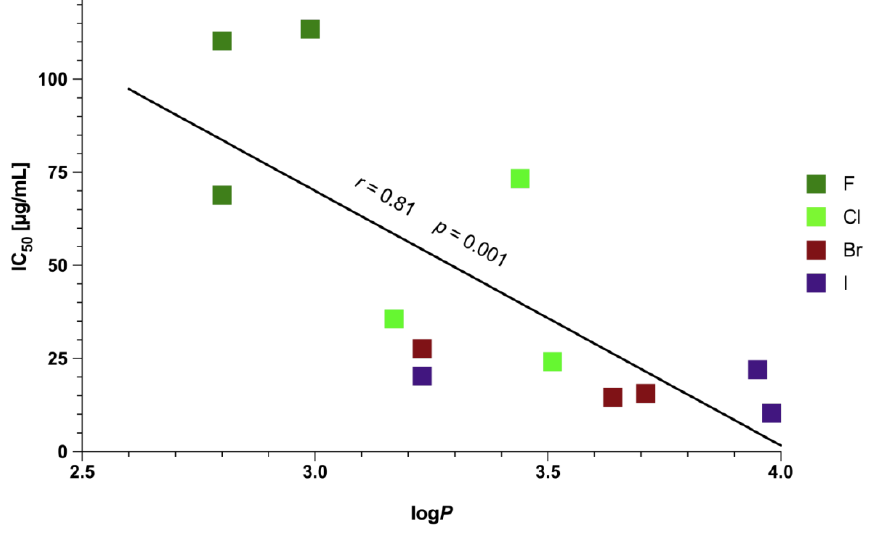
Figure 4. Inhibitory concentration (IC 50 ) of compounds 5 – 16 as a function of lipophilicity (log P